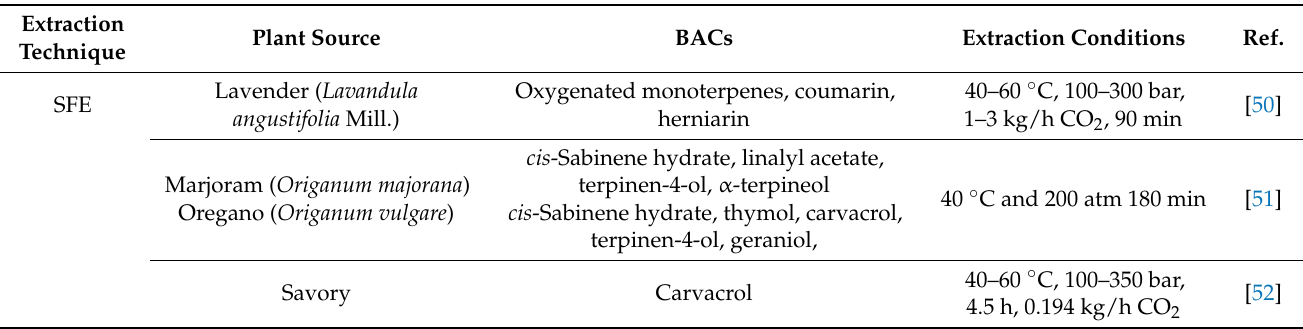
Table 1. Extraction of phenolic compounds from plant sources using green solvents and technologies. Extraction Plant Source BACs Extraction Conditions Ref. Technique Lavender ( Lavandula SFE angustifolia Mill.) cis -Sabinene hydrate, linalyl Marjoram ( Origanum majorana ) Oregano ( Origanum vulgare )